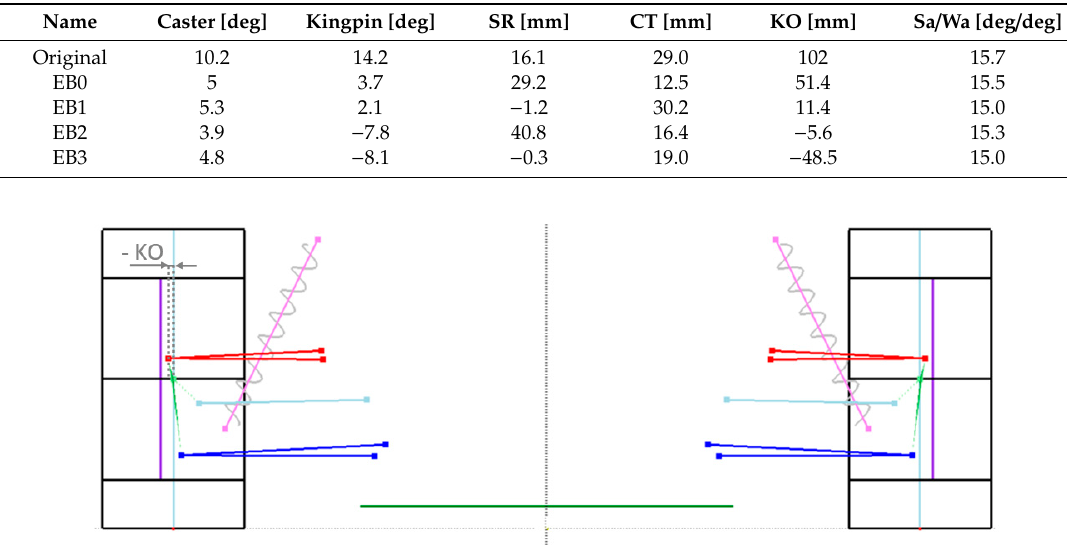
Figure 18. Schematic front view (yz plane) of the EB2 suspension, with small and negative KO.